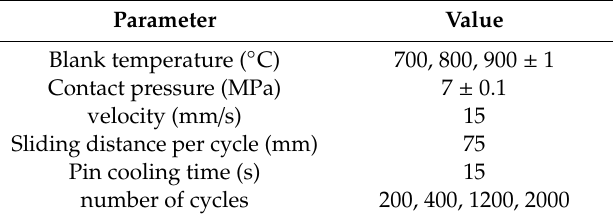
Table 3. Experimental plan of the wear